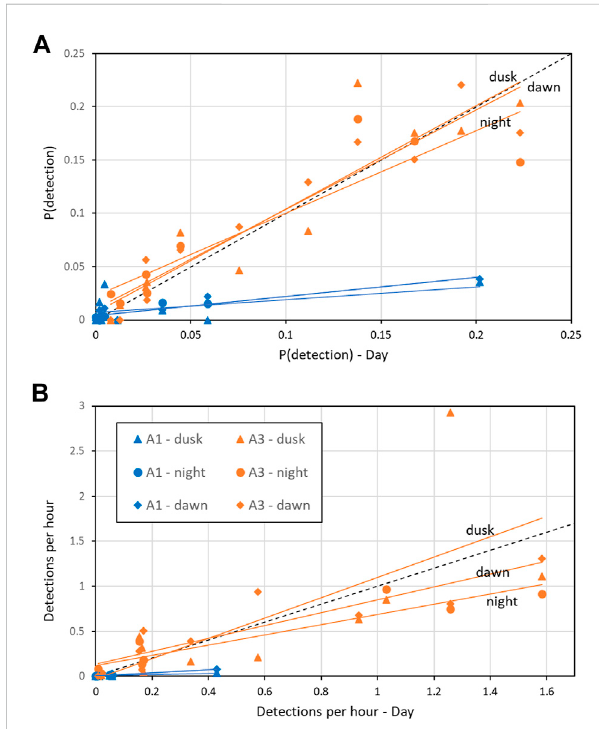
FIGURE 9 Effect of time of day on (A) Mean probability of detection in an hour; (B) Mean hourly detection rate. “ Day ” refers to measurements taken when the sun was above the horizon ( x -axis) and “ dawn ” / “ dusk ” during periods of nautical twilight and “ night ” when the solar elevation is below − 12 ° are shown on the y -axis for the corresponding month. Coloured, solid lines are the least-squares fi t by site (A1 and A3). Black dashed line indicates 1:1 correspondence (i.e., no change between sperm whale occurrence between dusk/night/dawn and day). See Table 5 for statistics of regression